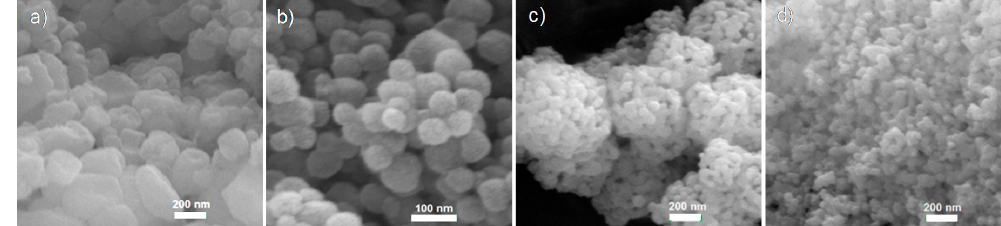
Figure 8. The representative SEM images of obtained ZnO NPs by the directly thermal decomposition and calcinations of Zn(OMe) 2 and Zn(O i Pr) 2 ; ( a ) ZnO -OMe ; ( b ) ZnO -O i Pr ; ( c ) ZnO -Me ; and ( d ) ZnO - i Pr .